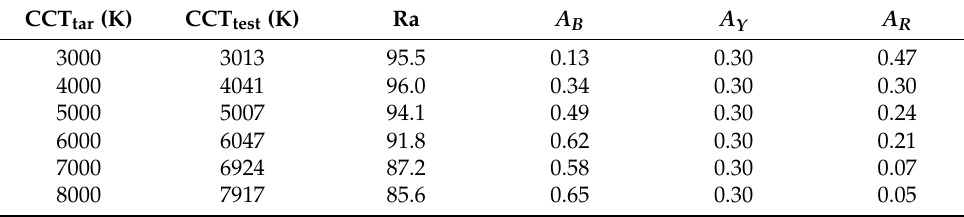
Table 3. Calculation parameters of spectral optimization using method